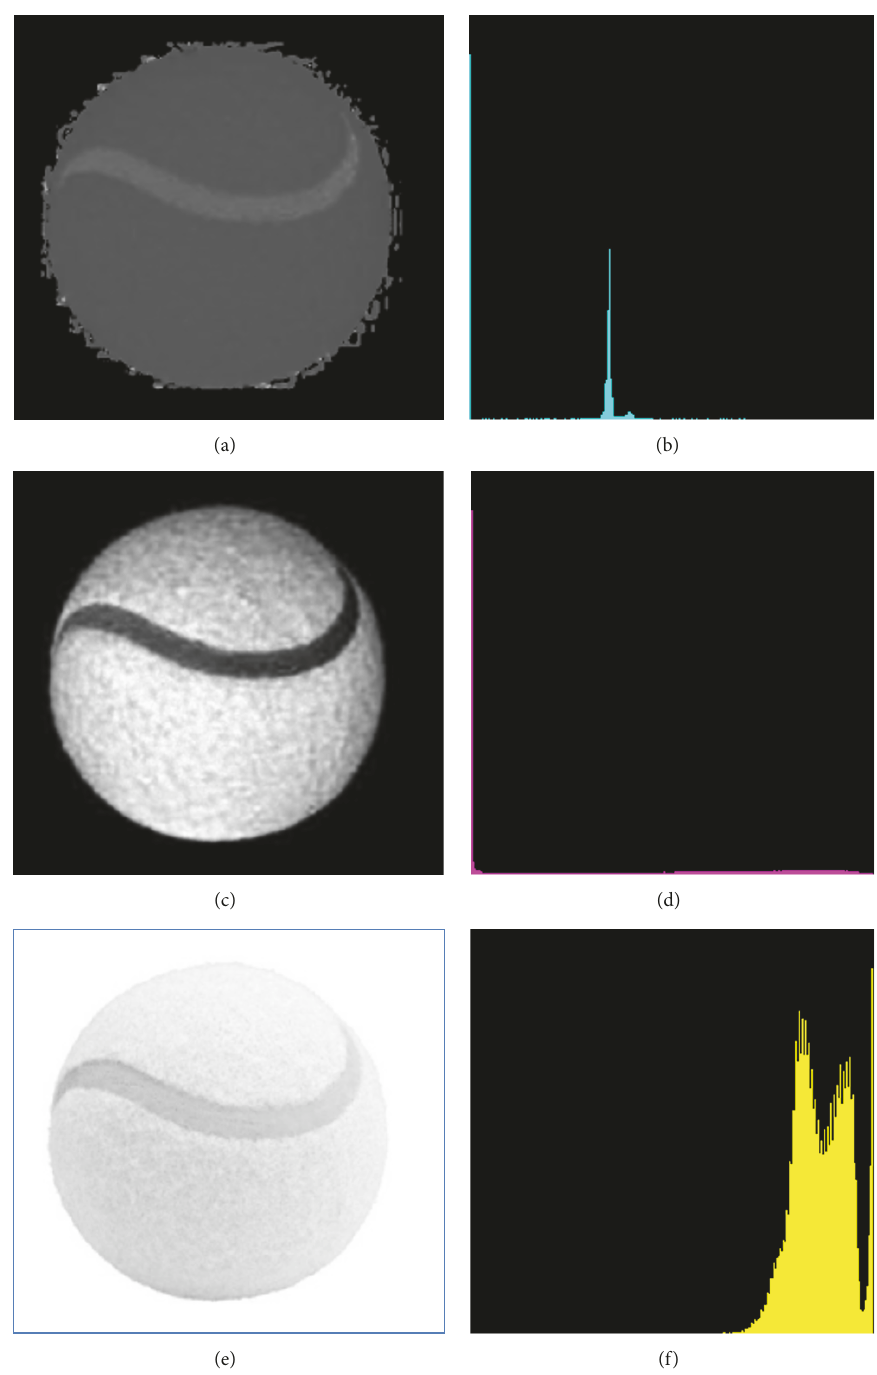
Figure 6: (a) ∼ (b) Image and corresponding histogram of H component for target, (c) ∼ (d) image and corresponding histogram of S component for target, and (e) ∼ (f) image and corresponding histogram of V component for target.